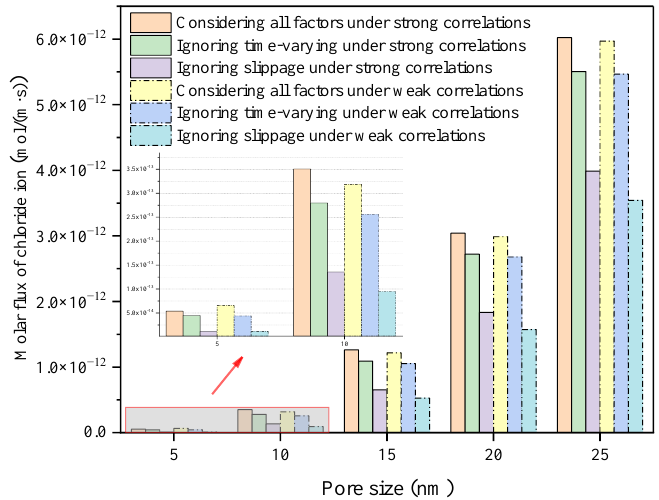
Figure 9. Molar flux of chloride ions in different pore sizes at steady state.